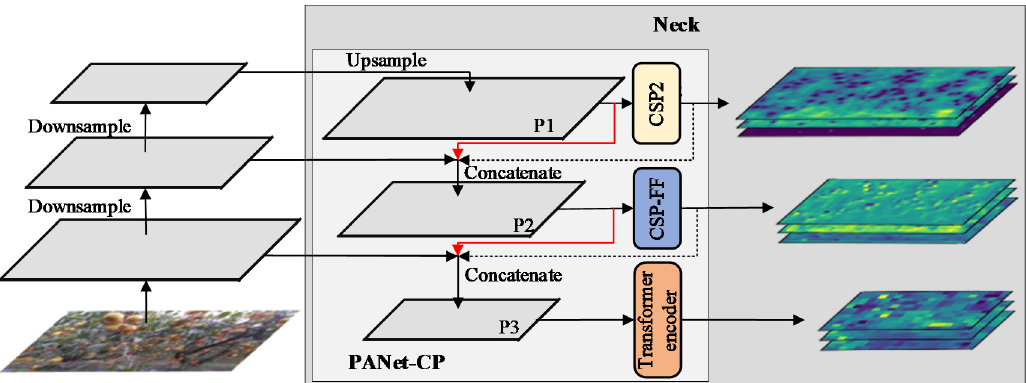
Figure 7. Structure of collaboration perception-oriented PANet (PANet-CP), with new skip connec- tions marked with red lines and removed connections marked with dashed lines.